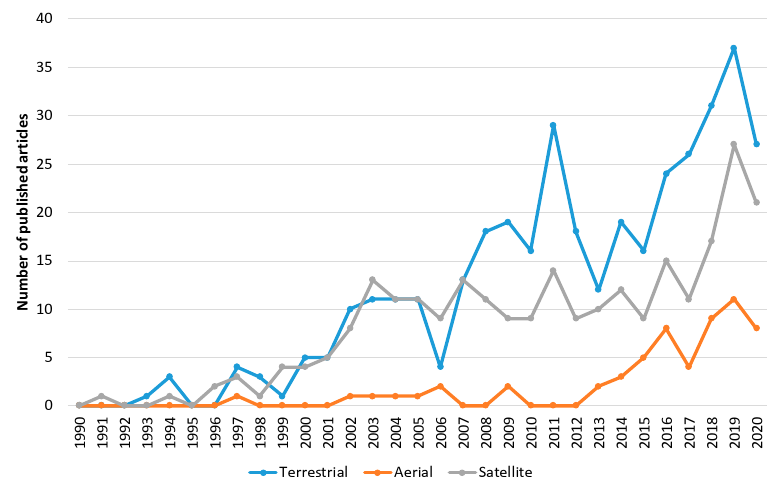
Figure 7. The number of published articles per year for terrestrial, aerial, and satellite-based systems. The analysis was performed for forest fire detection in the imaging research area. Data retrieved from Web of Science [134] for dates between 1990 to October 2020.